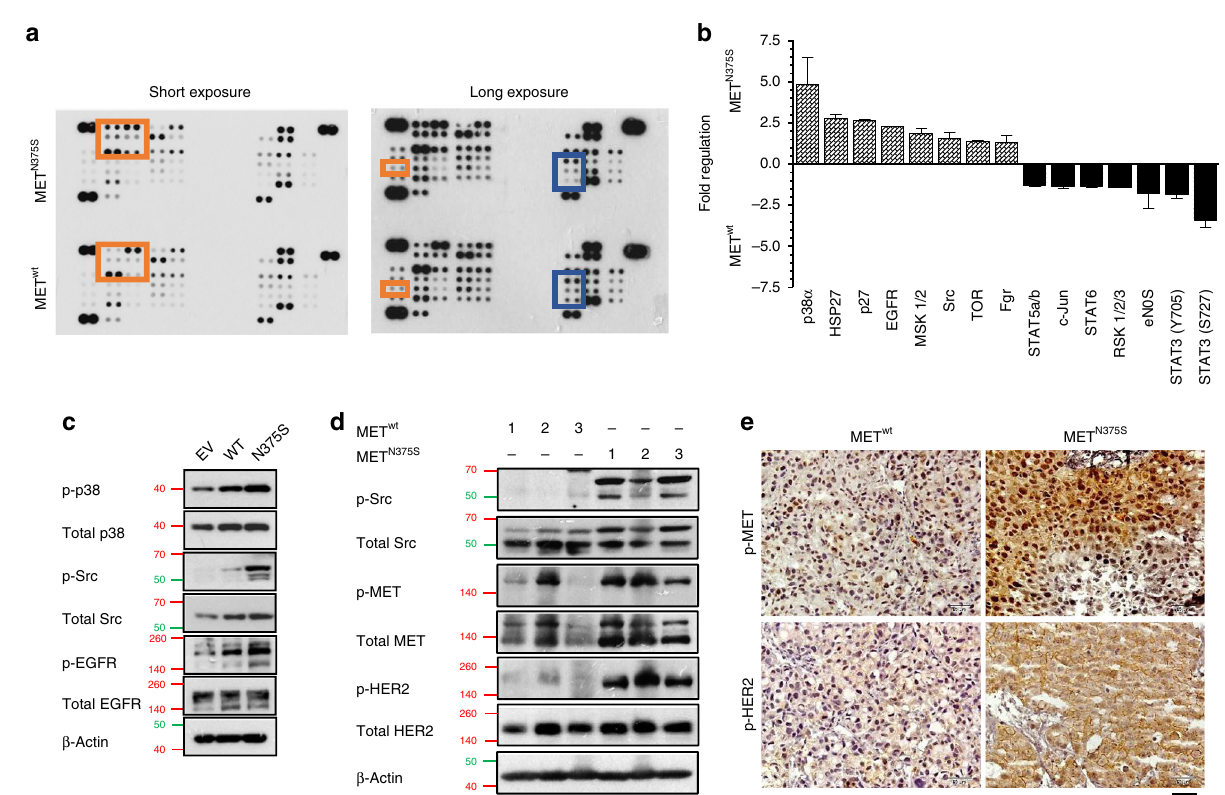
Fig. 3 Aberrant activation of MAPK, Src, and HER2 signaling in carcinoma cells harboring MET N375S mutation. a , b Isogenic H2170 MET wt-tGFP and MET N375S-tGFP cells grown in optimal growth conditions were harvested and subjected to Proteome Pro fi ler Human Phospho-Kinase Array. Dot plots with long and short chemiluminescence exposure are shown. Red indicates elevated phosphoproteins in MET N375S ; blue indicates downregulated proteins. Mean pixel density for each target spots was calculated with Quick Spots image analysis software, and tabulated as histogram demonstrating differential expressions of phosphoproteins in MET wt-tGFP and MET N375S-tGFP cells. Positive fold regulation indicates relative fold increase in MET N375S-tGFP cells; negative fold regulation indicates relative fold increase in MET wt-tGFP cells. Data expressed as mean of duplicate spots ± SD ( n = 1). c Immunoblotting was performed to evaluate and validate the changes in the signi fi cantly regulated targets identi fi ed in ( a ). β -Actin was used as a loading control. d , e Xenograft tumors from Fig. 2g were harvested for phosphoprotein analyses. Immunoblots ( d ) and immunohistochemistry staining ( e ) showing the changes induced by ectopic MET N375S expression in H2170 tumors. Representative blots and images are shown. Scale bar, 50 µ